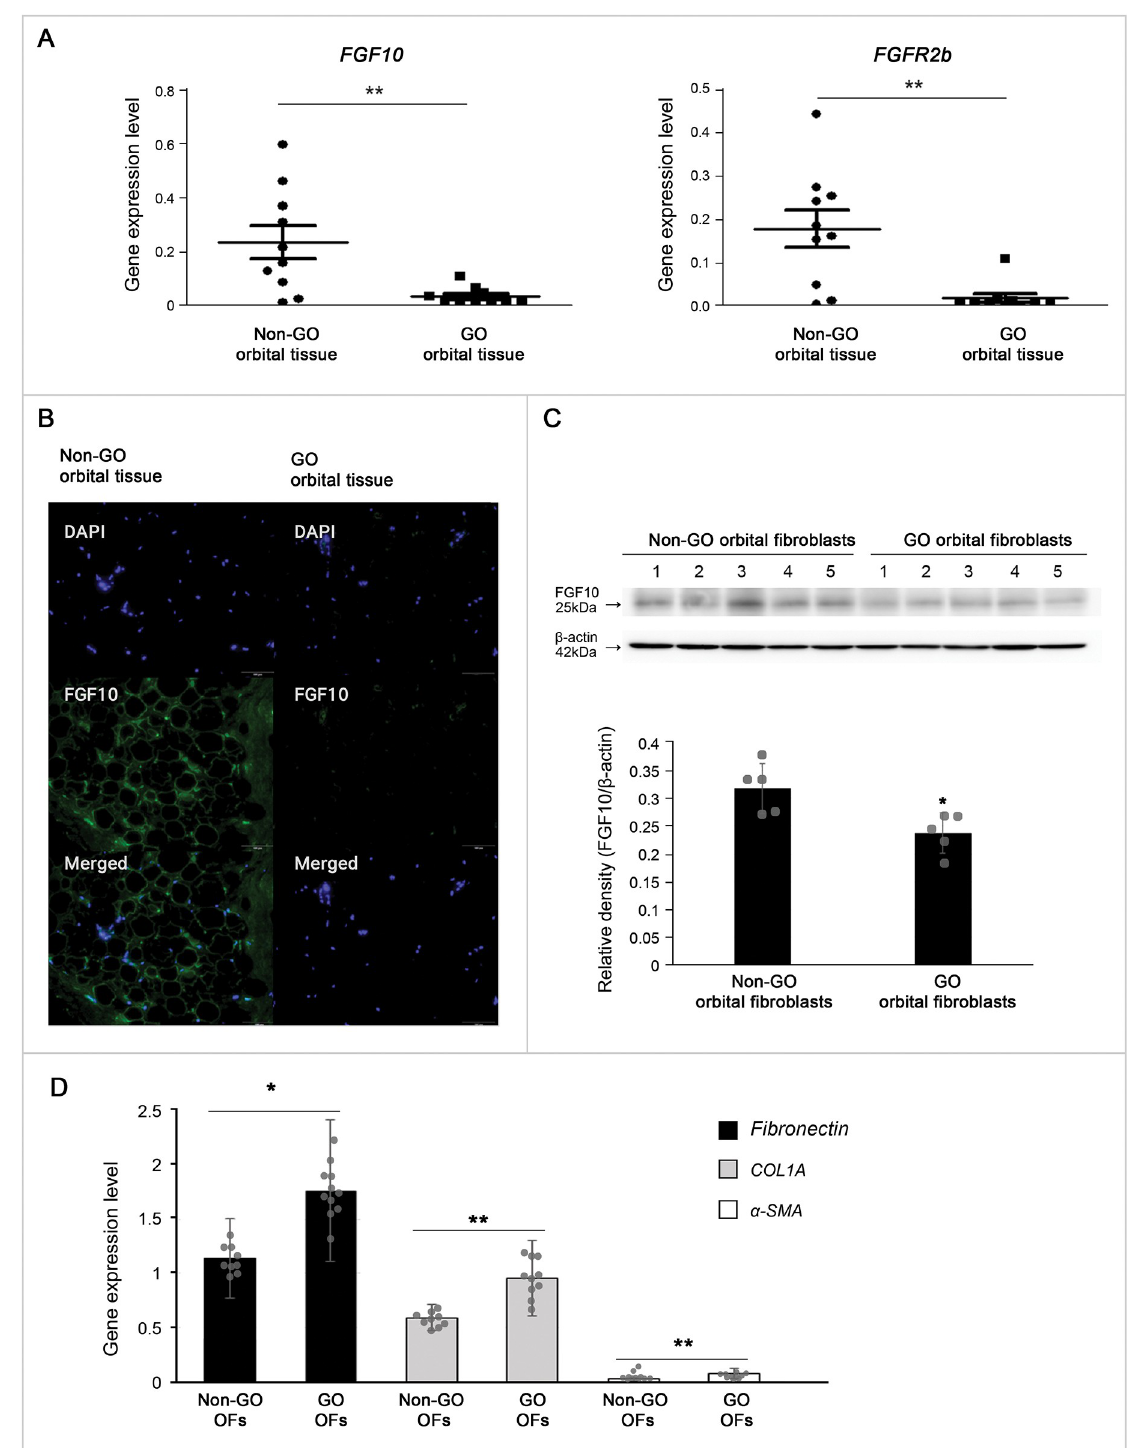
Fig 1. Expression of fibroblast growth factor 10 (FGF10) in Graves 0 orbitopathy (GO) and in non-GO tissues and cells. (A) Expression of fibroblast growth factor 10 (FGF10) and FGF receptor 2b (FGFR2b) mRNA in GO and non-GO orbital tissues. (B) Microscopy images showing the expression of FGF10 (green) and live-cell nuclei (4’,6-diamidino-2-phenylindole dihydrochloride; blue) in GO and non-GO orbital tissues. (C) Expression of FGF10 protein in GO and non-GO orbital fibroblasts (OFs). Bar graphs show the relative density of FGF10 normalized to the level of β -actin and are represented as means ± standard deviation. (D) Gene expression of fibronectin, collagen I α , and α - smooth muscle actin in GO and non-GO OFs. Experiments were performed at least three times using different strains. � p < 0.05, �� p <